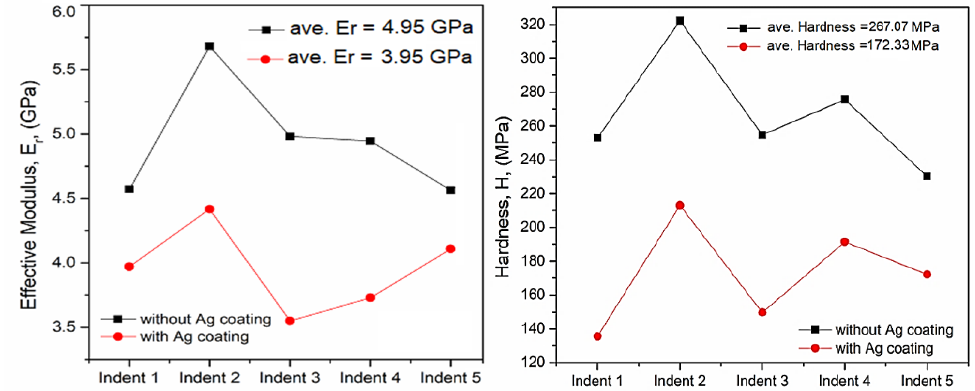
Figure 14. The effective modules and hardness extracted from indentation measurements. Table 4. The individual and average hardness and modulus values for the uncoated and coated Arboblend V2 Nature pellets extracted from nano-indentation measurements.